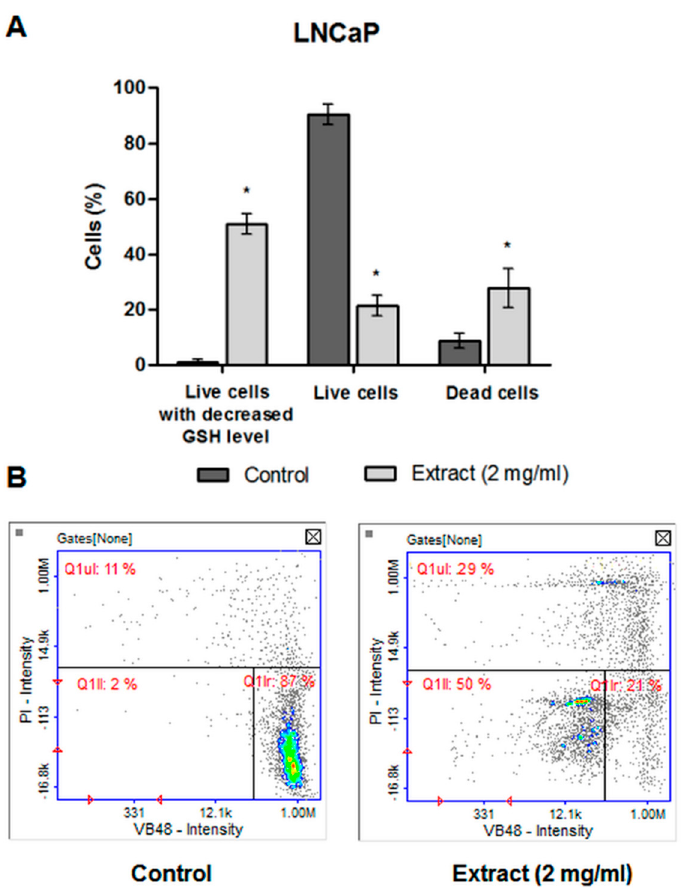
Figure 8. ( A ) Detection of the level of cellular thiols in LNCaP cells by image cytometry. The LNCaP cells were treated with 2 mg/mL of CA extract or DMSO as a vehicle in control cultures for 48 h. Data were presented as mean ± SD obtained from three independent experiments. * p < 0.05 vs. control. ( B ) Representative histograms (Q1II—PI negative cells with decreased GSH level, Q1Ir—healthy cells, Q1ur—dead